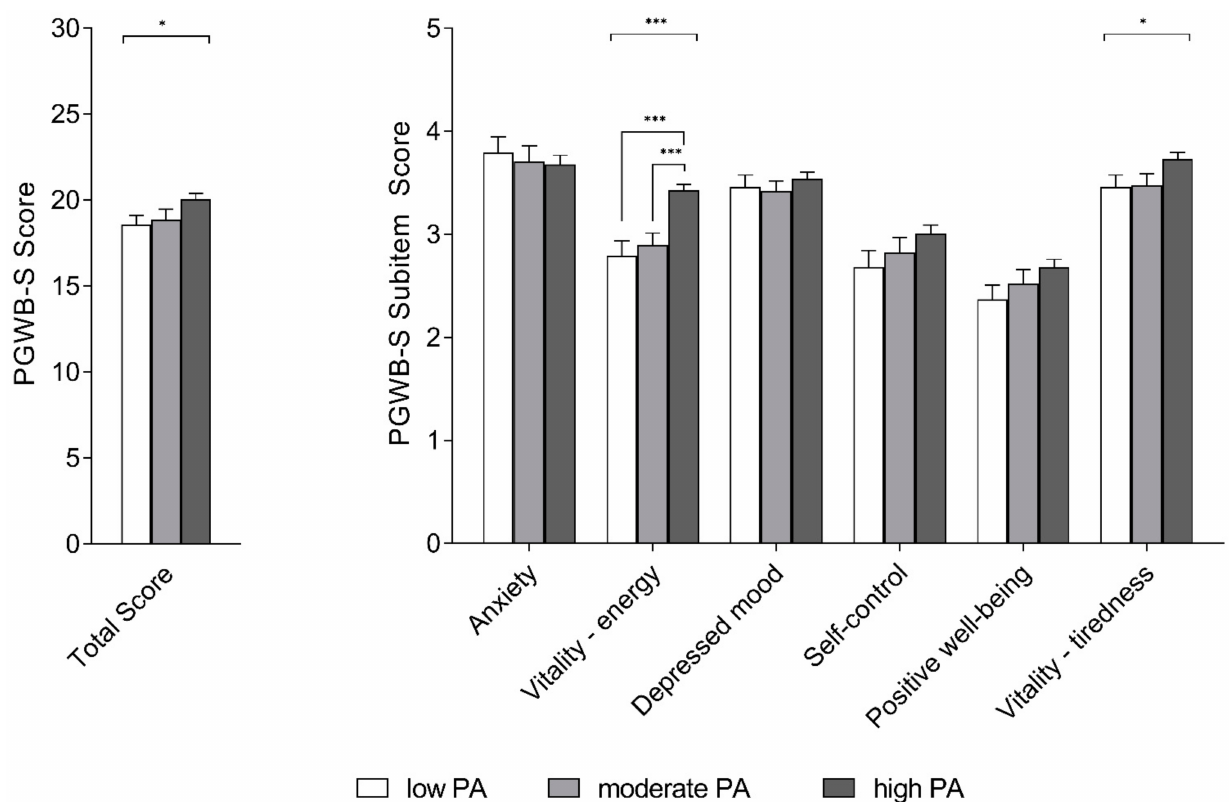
Figure 2. Psychological well-being in participants across the levels of PA (low, moderate, high). Left: PGWB-S total score; Right: PGWB-S subitems. Data are presented as mean score with standard error. Asterisks denote statistical significance (* = p < 0.05; *** = p <